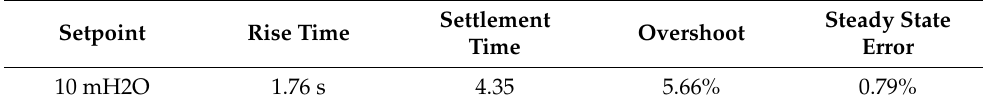
Table 3. Time characteristics of the proposed fuzzy controller response (single pump). Setpoint Rise Time